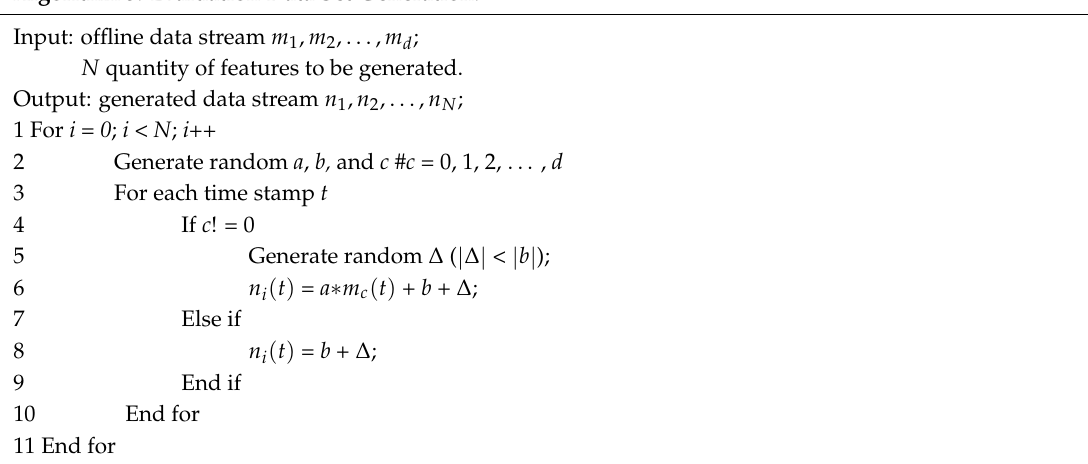
Algorithm 5. Evaluation Data Set